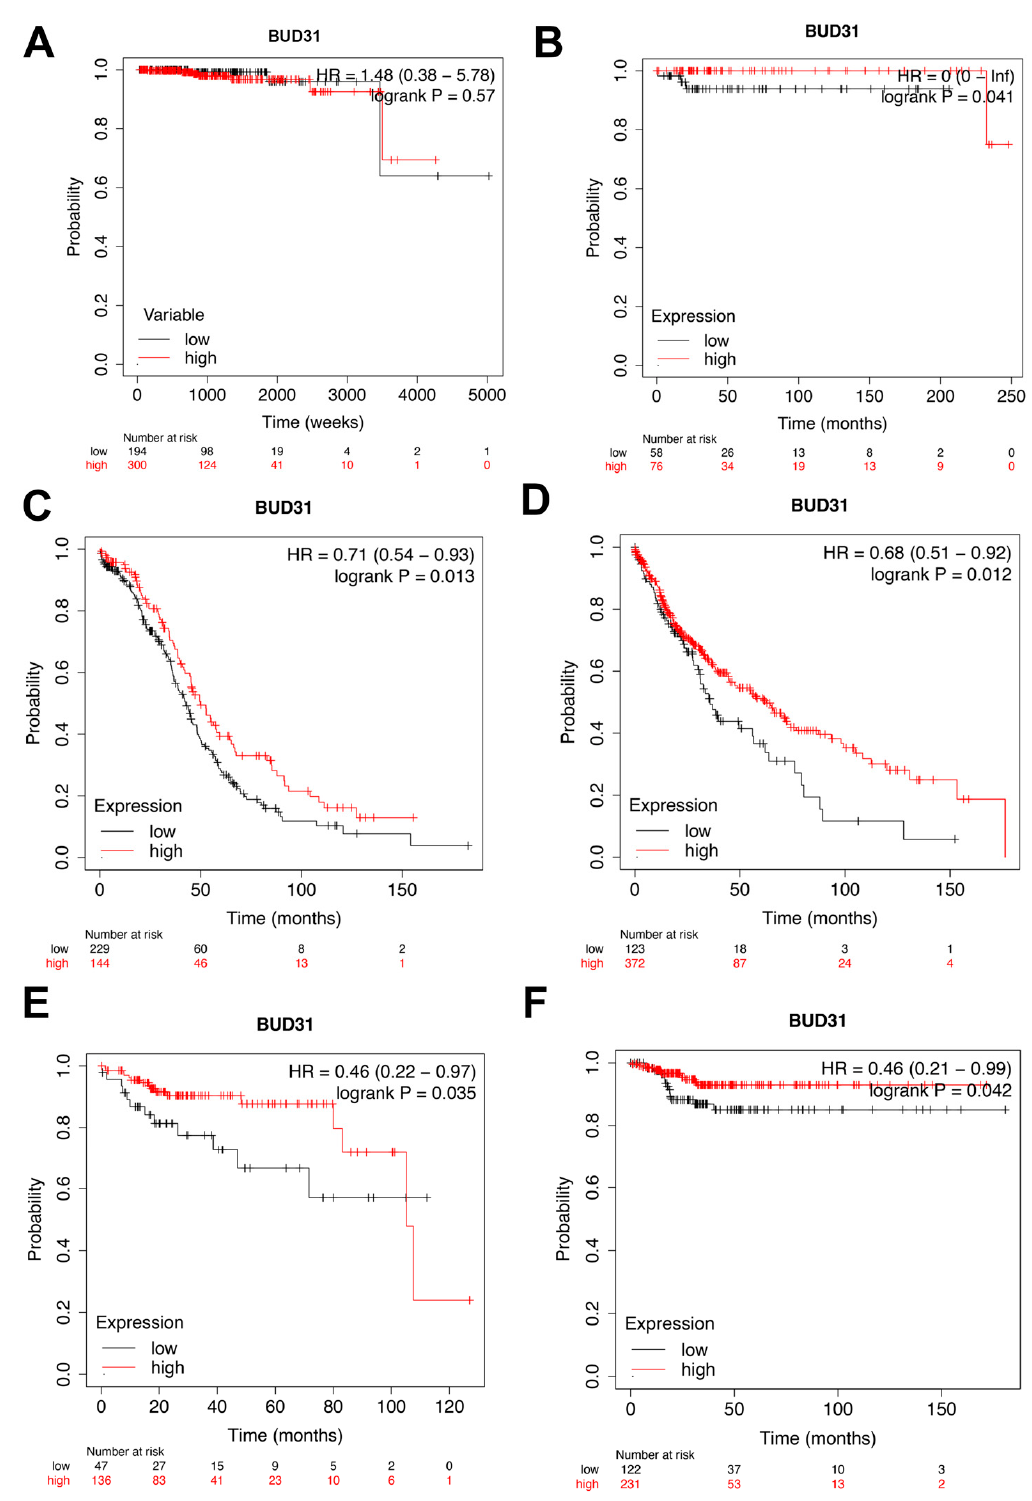
Figure 2. Kaplan–Meier plots indicating overall and return-free survival in relation to BUD31 expression in different cancers. ( A ) Prostate adenocarcinoma (OS). ( B ) Testicular germ cell tumor (OS). ( C ) Ovarian cancer (OS). ( D ) Lung squamous cell carcinoma (OS). ( E ) Kidney renal papillary cell carcinoma (RFS). ( F ) Thyroid carcinoma